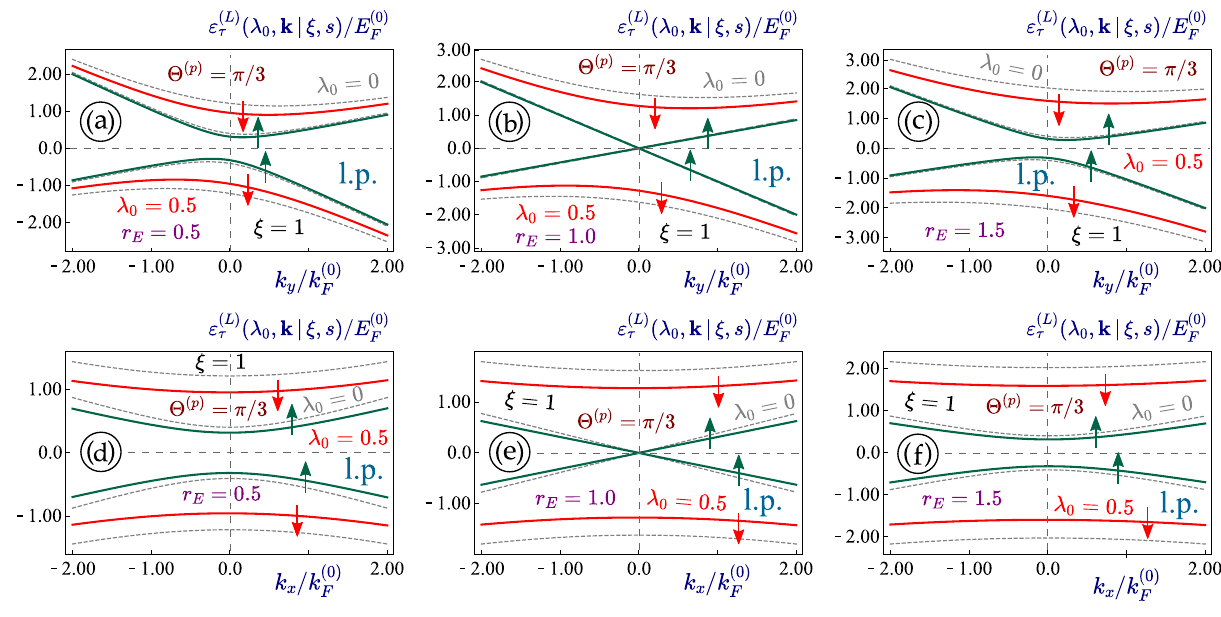
( L ) (cid:31) k 1, s ) for the case of linearly-polarized irradiation ξ Figure 4. (Color online) Energy dispersions ε 0 , 1 ( τ | = =± 0 ) and the same lattice applied to a 1T ′ -MoS 2 lattice. The dispersions for non-irradiated materials ( (cid:31) 0 = parameters are also presented as dashed and gray curves for comparison. Upward and downward spin states 1 are denoted by green and red arrows, respectively. The linear-polarization angle 1 and s with s = − = + 0.5 are chosen for all plots. � ( p ) π/ 3 of a dressing field and the electron-photon coupling parameter (cid:31) 0 = = Three upper panels ( a )-( c ) show the initially asymmetric k y -dependence of the electron band structure, while the lower ones ( d )-( f ) demonstrate its k x -dependence. Both rows of panels are related to a specific value of 0.5 [( a ), ( d )], 1.0 [semi-metallic; ( b ), ( e )] and 1.5 [( c ), ( f )], as labeled. Here, K external electrostatic field r E = 1 ) was selected for all -valley ( ξ =